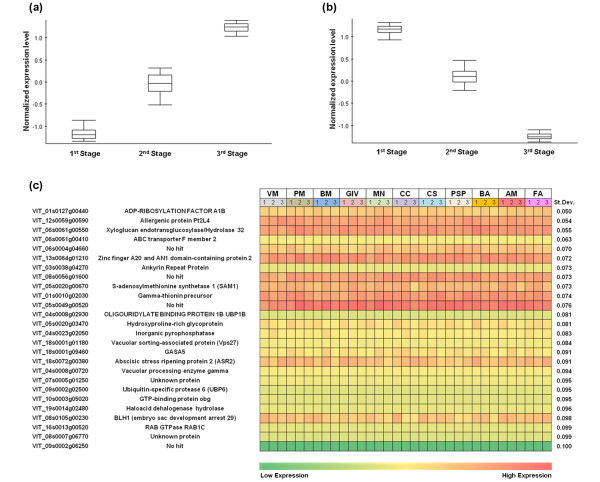
Non-plastic grapevine genes. Grape berry development markers. Box plots of the 115 most strongly upregulated (a) and the 90 most strongly downregulated genes (b) showing similar expression profiles in all vineyards. Box plots were created using Expander 6.0 [85]. The central line and outside edge of each box indicate the 50th, 25th, and 75th percentiles of expression data, respectively. Vertical lines on the two sides of the box represent the minimum and the maximum of all data, respectively. (c) Non-plastic constitutive genes. Genes with constant expression levels throughout berry development in all 11 different vineyards were ranked according to the lowest standard deviation among samples. The average expression value of the three biological replicates is indicated. The first 26 genes are shown (SD = 0.050-0.100).